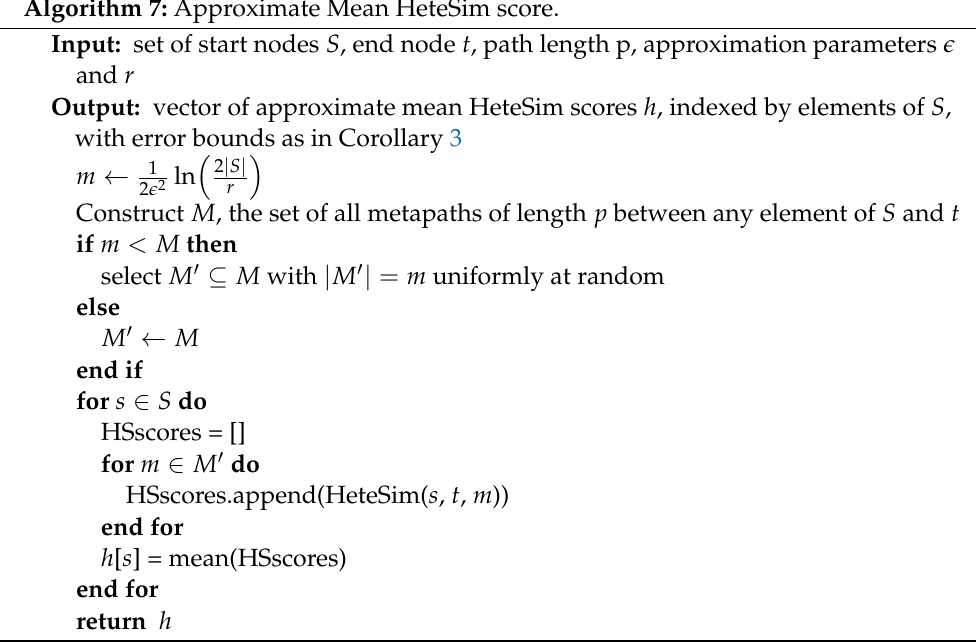
Algorithm 7: Approximate Mean HeteSim